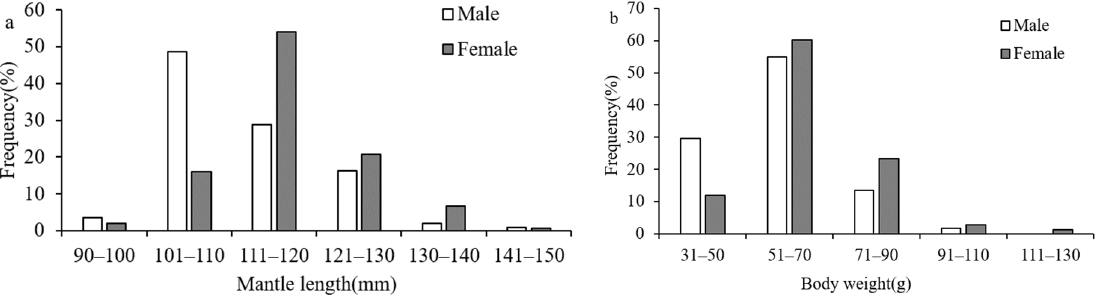
Figure 2. Distribution of ML ( a ) and BW ( b ) of B. magister shevtsovi